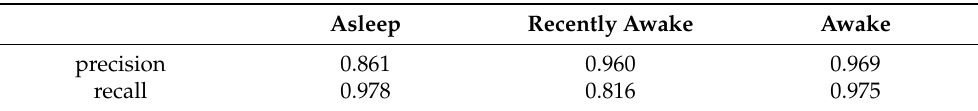
Table 2. Precision and recall of the first stage of wake-up